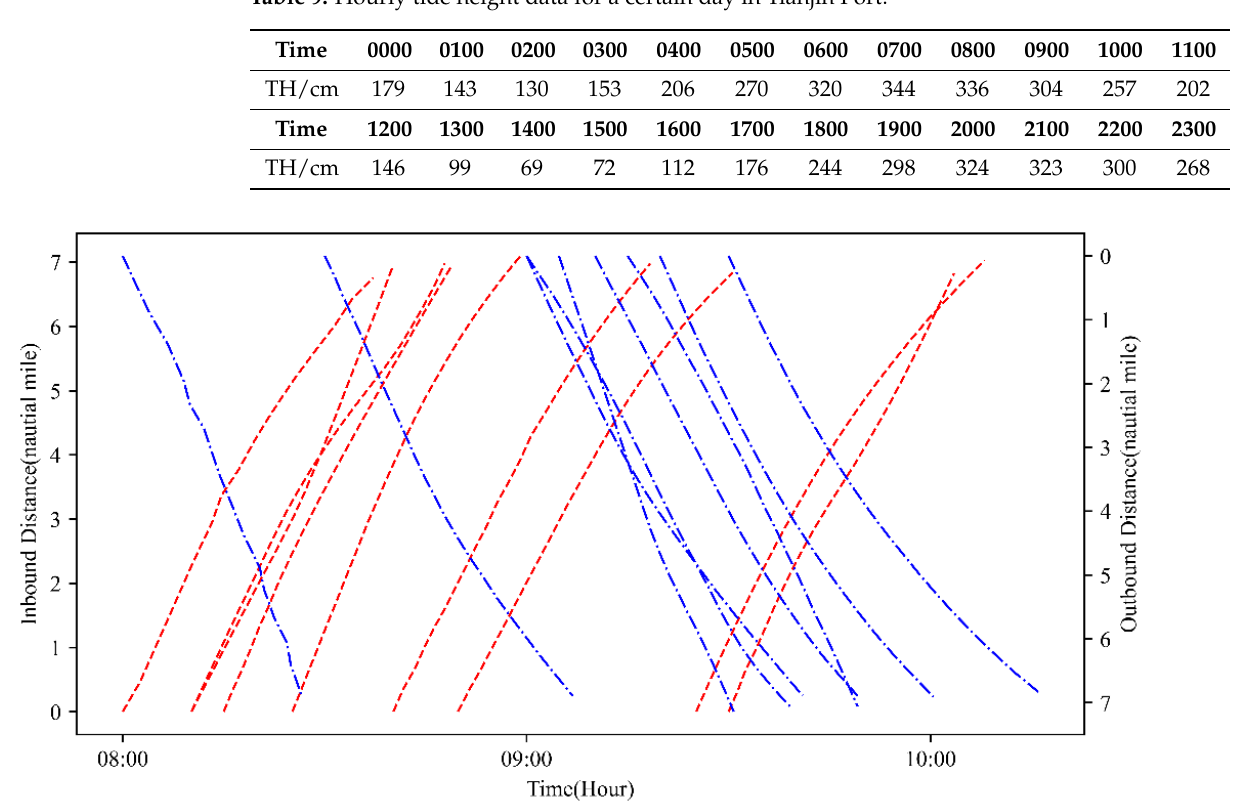
Table 9. Hourly tide height data for a certain day in Tianjin Port.